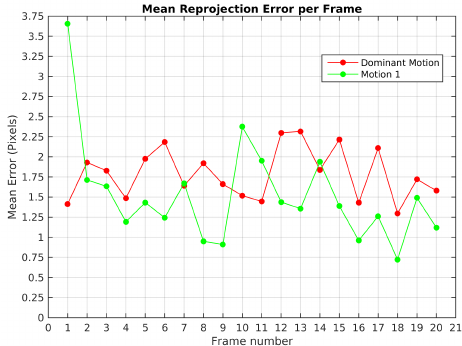
Figure 19. Mean reprojection error in Scene 1 with baseline method.